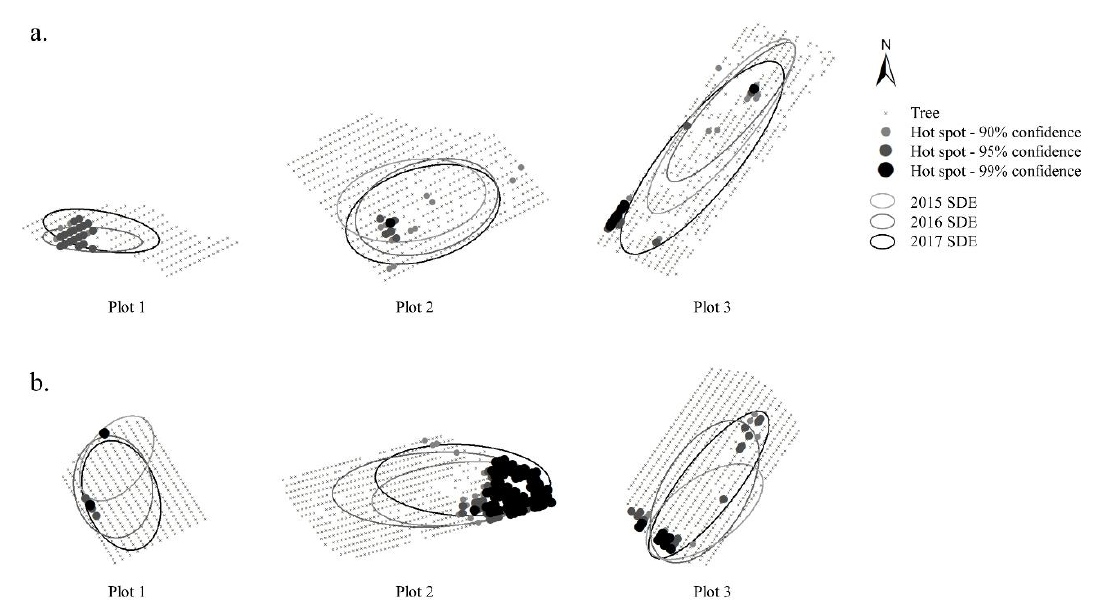
Figure 3. Getis-Ord Gi* optimized hot spot analysis of S. exitiosa infestation in plots treated with ( a ) insecticide and ( b ) mating disruption during the study period (2015–2017). Maps also show standard deviation ellipses (SDE) of the infestation area for each year.